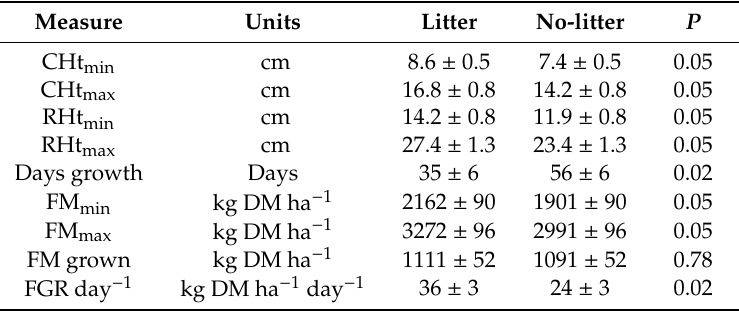
Table 1. Canopy characteristics and litter treatments’ e ff ect (mean ± SE) on pastures’ initial and final plate meter compressed height (CHt min and CHt max ), initial and final ruler height (RHt min and RHt max ), days in the growth period (days growth), initial and final forage mass (FM min and FM max ), forage mass grown (FM grown) and forage growth rate per day (FGR day − 1 ).